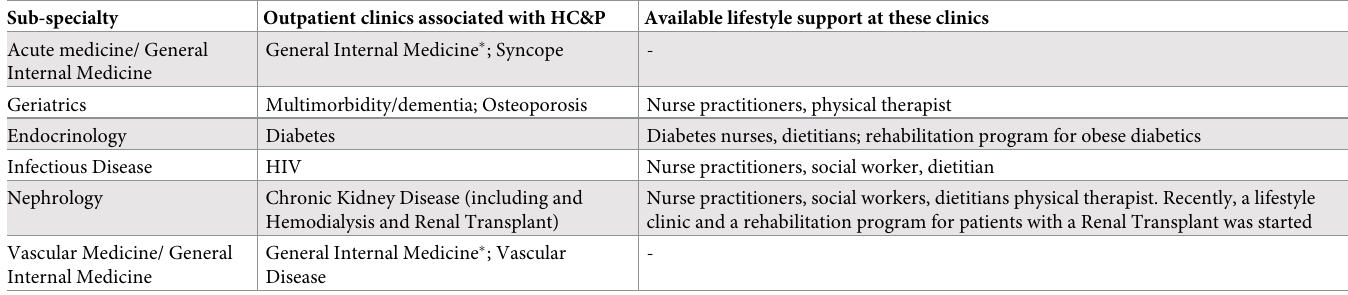
Table 2. Characteristics of the involved outpatient clinics with regard to HC&P.